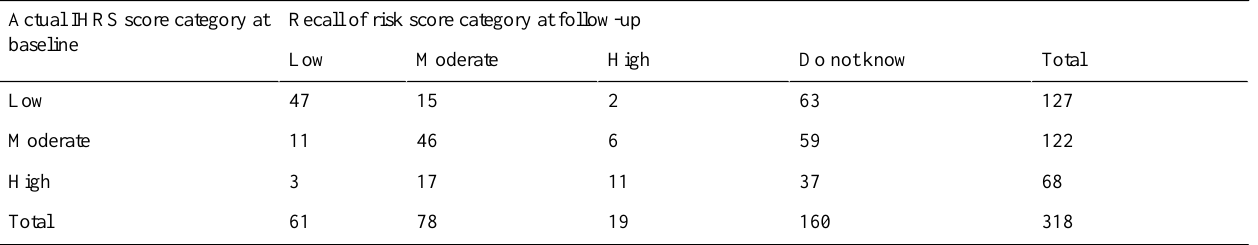
Table 4. Agreement between MI risk score results and participants recall of risk score at follow-up.